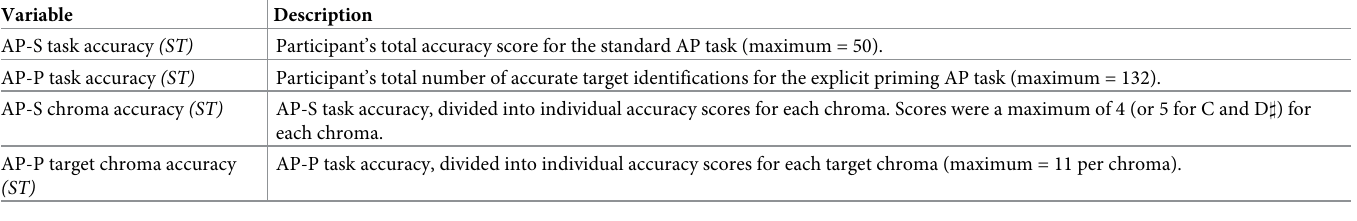
Table 2. Accuracy variables derived from the standard AP (AP-S) and explicit priming (AP-P) tasks.